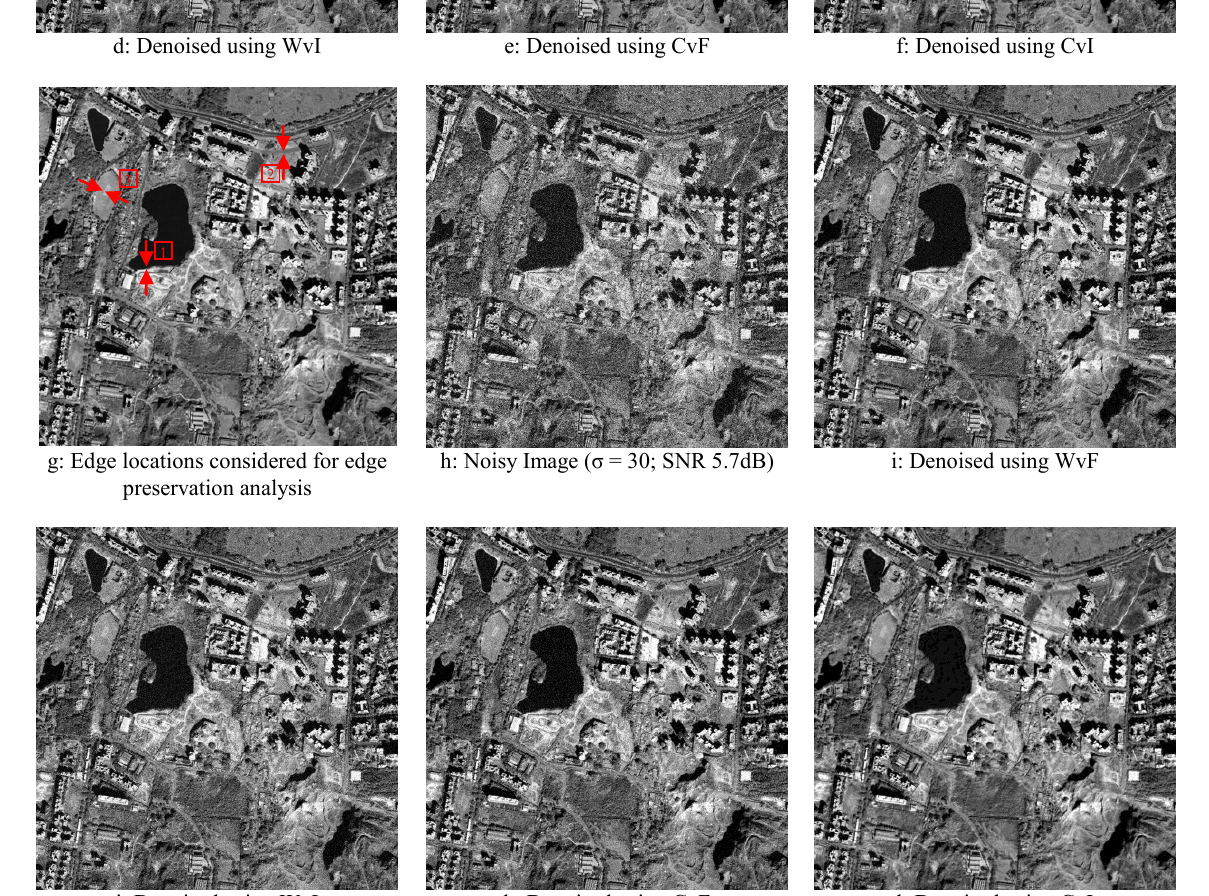
Fig. 5: Denoising of Quickbird image of Powai area in